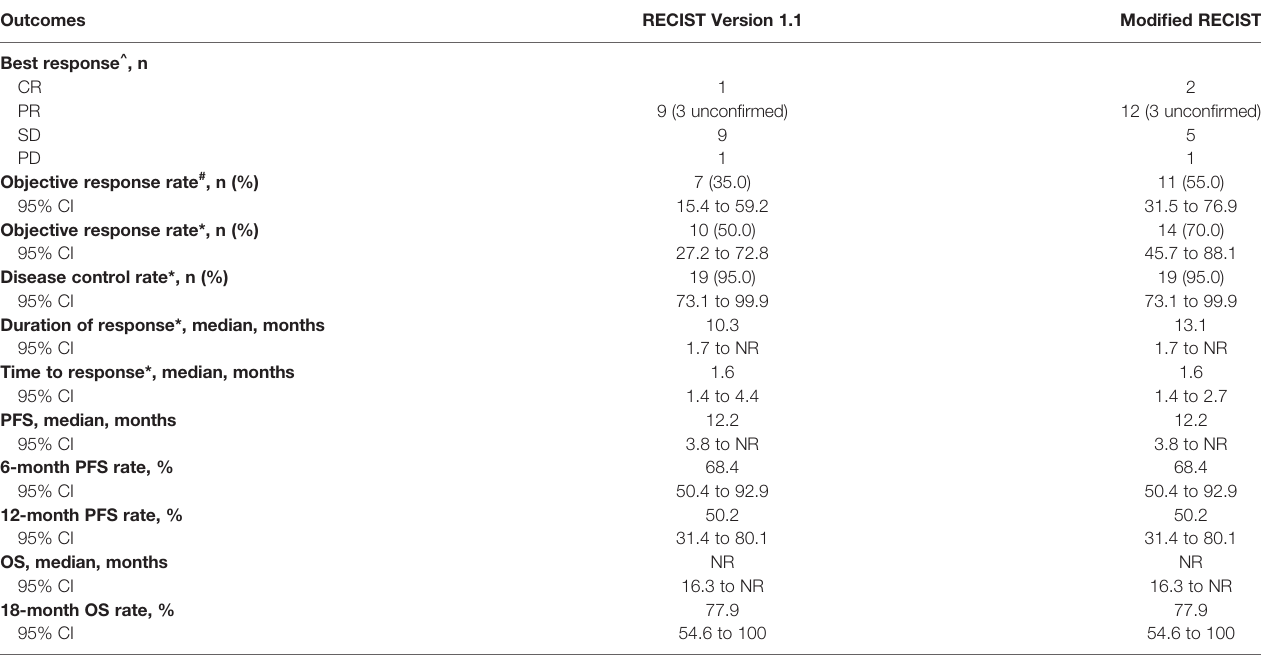
TABLE 3 | Summary of ef fi cacy measures in the ef fi cacy-evaluable population (N=20). Outcomes RECIST Version 1.1 Best response ^ ,